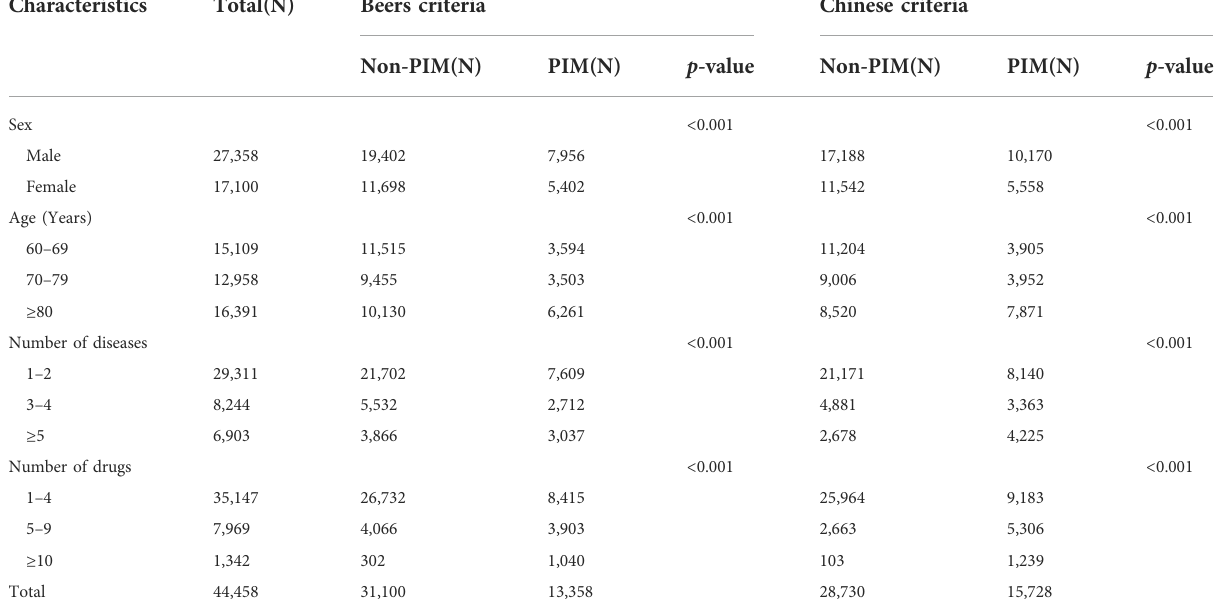
TABLE 1 Basic characteristics of patients.